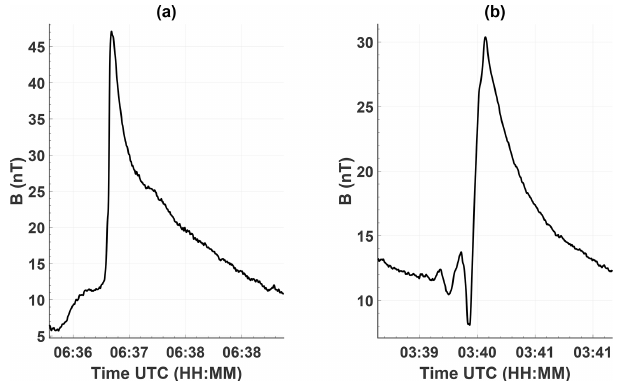
Figure 6. Example of a typical steepened wave without dispersive effects on 20 November 2015 (a) and with dispersive effects on 3 August 2015 (b) .